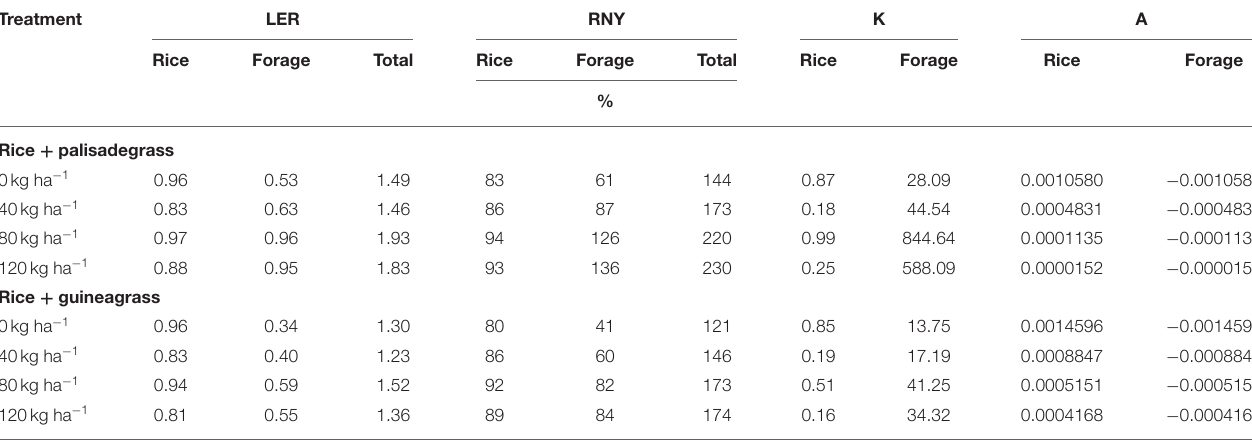
TABLE 5 | Land equivalent ratio (LER), relative nitrogen yield (RNY), relative crowding coefficient ( K ) and aggressivity ( A ) of upland rice, palisadegrass, and guineagrass intercropped as a function of sidedress nitrogen rates for upland rice crop. Treatment LER RNY K A Rice Forage Total Rice Forage Total Rice Forage Rice Forage